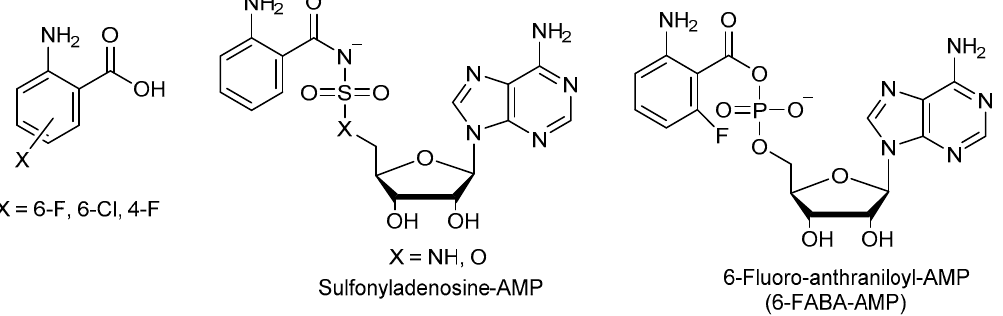
Figure 3. Previously reported inhibitors of PqsA.